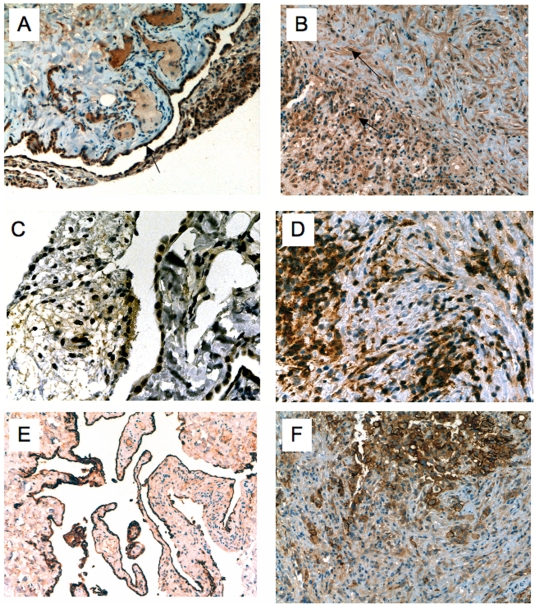
Protein expression of selected genes, AGGF1, TYMS and MSLN by immunohistochemistry.A–C–E: normal parietal pleura. B–D–F: Biphasic mesothelioma with epithelial and sarcomarous components. A–B (x20): AGGF1(VG5Q) mRNA was overexpressed in mesothelioma, and clearly protein was expressed (brown) in both tumour components (arrows). Strong expression in normal mesothelium was seen (arrow) but the majority of endothelial and other pleural cells were negative. C–D (x40): TYMS (Thymidylate synthase) mRNA was overexpressed, also on the protein level (brown), mostly in the epithelial component (arrow) of tumour. Normal pleura was negative. E–F (x20): MSLN (Mesothelin) mRNA was not differentially expressed, that could be explained by the intense protein expression not only in epithelial tumour cells, but also in normal mesothelial and stromal cells.